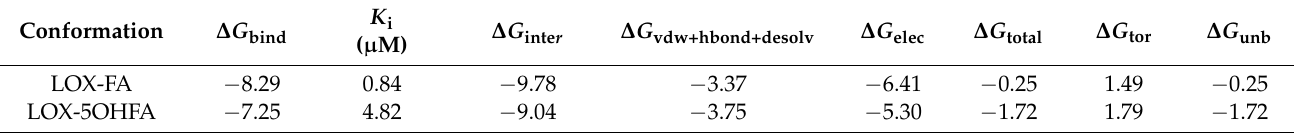
Table 3. Estimated important thermodynamic parameters in kcal/mol ( ∆ G bind free energy binding, K i constant of inhibition, ∆ G ∆ G ∆ G ∆ G tor torsional free energy, total final total internal energy, unb unbound system’s energy, elec electrostatic energy, and ∆ G vdw+hbond+desolv is the sum of the effect of dispersion and repulsion ( ∆ G vdw ), hydrogen bond ( ∆ G hbond ), and desolvation ( ∆ G desolv )) obtained after the molecular docking simulation. The intermolecular energy, ∆ G inter , represents the sum of ∆ G vdw+hbond+desolv and ∆ G elec